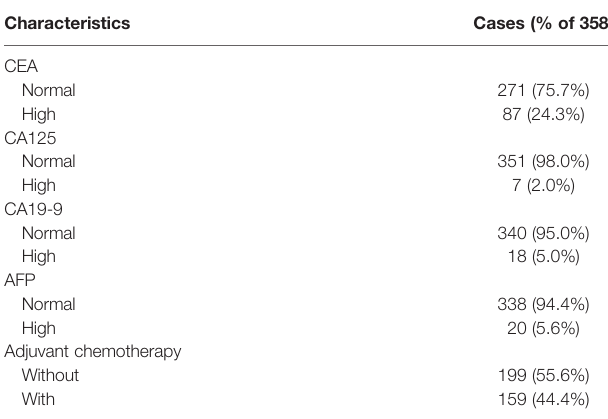
TABLE 1 | Baseline patient clinicopathological